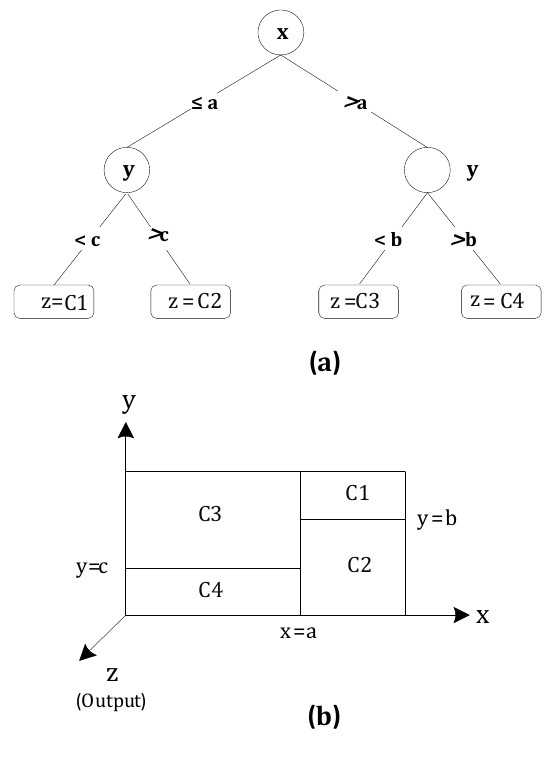
Figure 1. An example of a decision tree for classification (a) binary decision tree (b) feature space partitioning